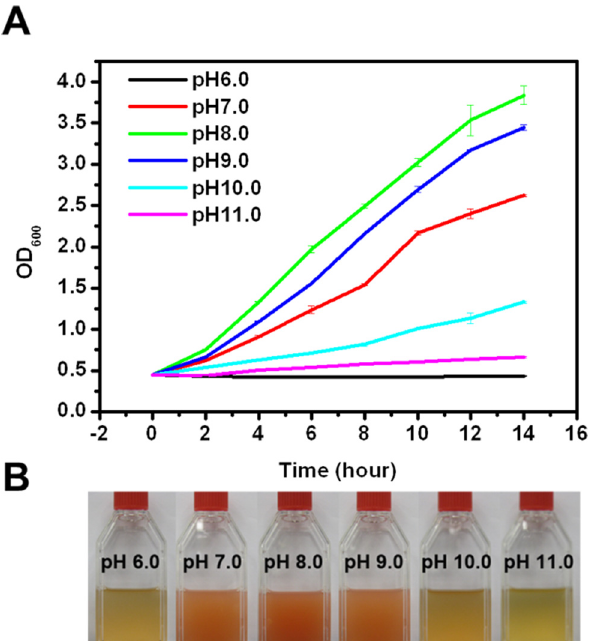
Fig 2. Analysis of A . andensis ANESC-S T resilience to different pH conditions. (A) Growth curves of A . andensis ANESC-S T in LB broth with varied pH conditions (Initial OD 600 (cid:2) 0.4). (B) Cultures of A . andensis ANESC-S T after 14 hours in LB broth with varied pH conditions (Initial OD 600 (cid:2) 0.4).